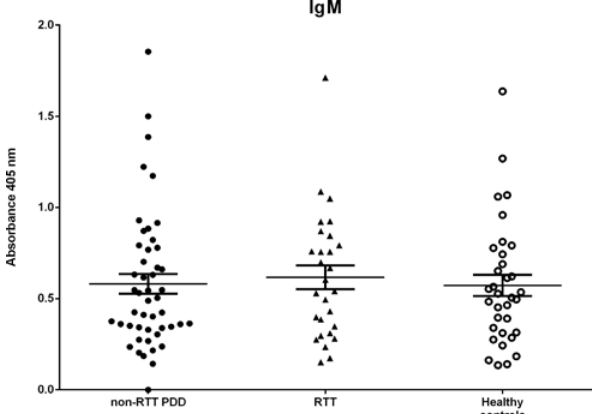
Figure 4. Data distribution of IgM antibodies against hMOG(1- 117) identified by SP-ELISA in RTT (  ), non-RTT PDD patient sera ( ● ), and healthy controls ( ○ ), respectively. Mean group values and standard error of mean (SEM) are